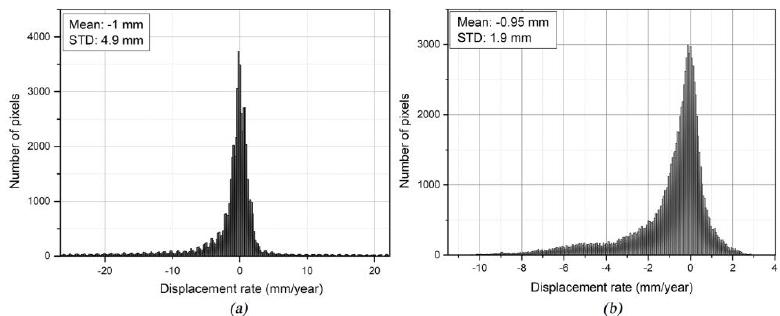
Figure 4. Histogram distribution for the ERS-1/-2-derived displacement rates from May 1993 to February 2006: ( a ) the corresponding histogram of the PSI measurements from the ERS-1/-2 data; and ( b ) the corresponding histogram of the SBAS measurements from the ERS-1/-2 data.